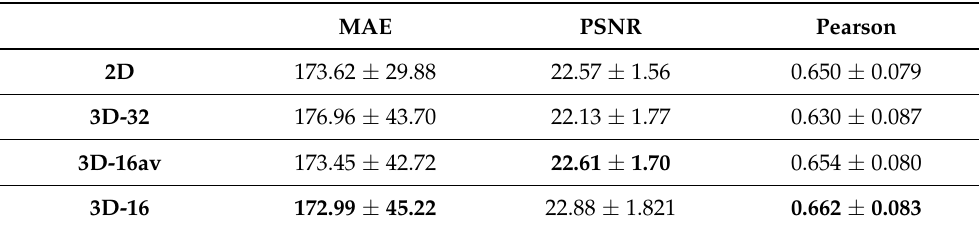
Table 8. Head dataset Fat with Atrous-Net. Mean Absolute Error, PSNR and Pearson coefficient within the fat on the head data set obtained using Atrous network with different convolutions and reconstructions.